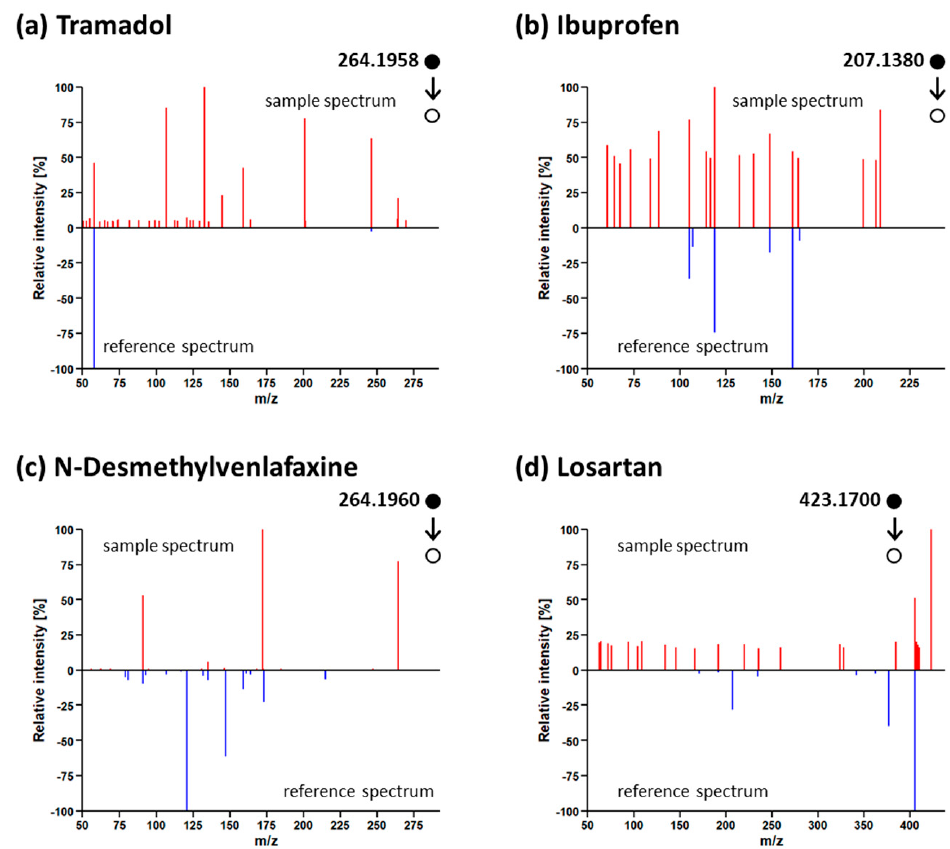
Figure 5. Examples of tandem mass spectra obtained from analysing wastewater samples with Orbitrap that showed insufficient spectral similarity to reference spectra of ( a ) tramadol (interfering peaks), ( b ) ibuprofen (noisy sample spectrum), ( c ) N-desmethylvenlafaxine (noise and/or interfering peaks), and ( d ) losartan (noisy spectrum and interfering peaks) stored in the Eawag collection. Black dots indicate precursor mass that triggered the MS/MS spectra (hollow dot).